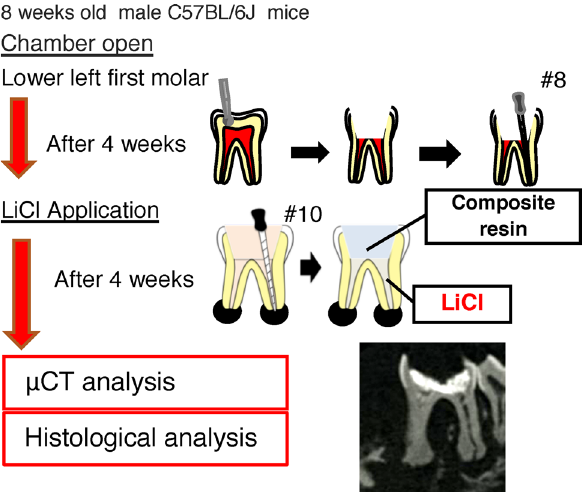
Figure 4. In vivo activation model of the Wnt/β-catenin signaling pathway. The pulp chamber of the lower first molar was exposed to the oral cavity. At 4 weeks after pulp exposure, root canal cleaning was performed using the # 10 K file. After root canal cleaning, LiCl was applied to the root canal, and the periapical lesions were evaluated by micro-CT and histological analysis. A representative image for the micro-CT is shown.